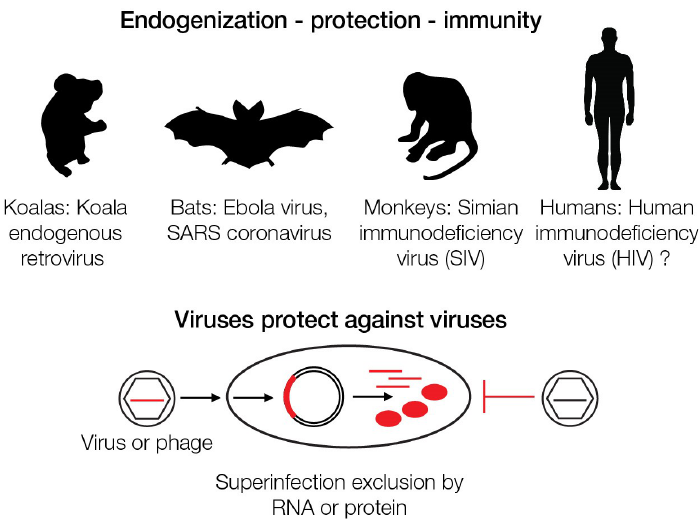
Figure 5. Viruses protect against viruses and phages protect against phages. The infection of a host cell can result in the exclusion of superinfecting viruses or phages. The phenomenon is exemplified in koalas, bats and monkeys, as discussed in the text. The possible emergence of resistance to HIV is speculative (modified from [ 67